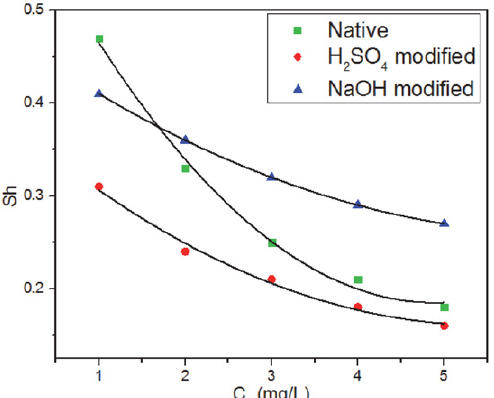
Figure 9. Influence of Sherwood number on initial As(III) concen- tration using native and chemically modified brick kiln